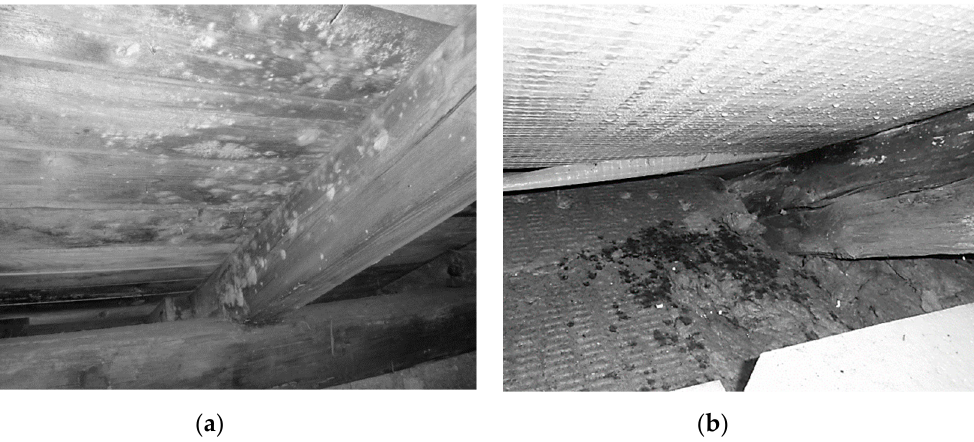
Figure 2. ( a ) Mould growth on wooden sheathing; ( b ) droplets of condensate on the PE (polyethylene) underlay foil and wetted mineral wool insulation.